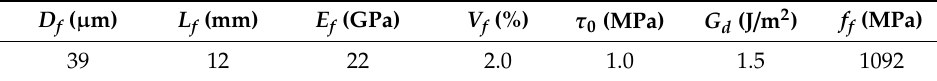
Table 1. Parameters used in the analysis with fiber-bridging